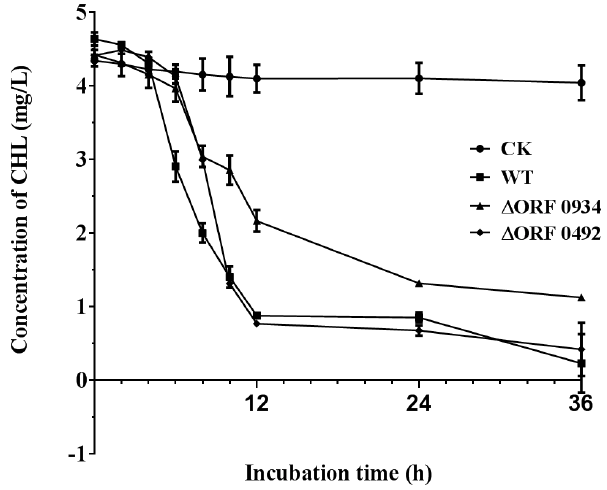
Figure 9. Degradation rates of chlorimuron-ethyl by strains WT, ∆ ORF 0934, and ∆ ORF 0492. CK: controls without bacteria. The error bar indicates one standard deviation.